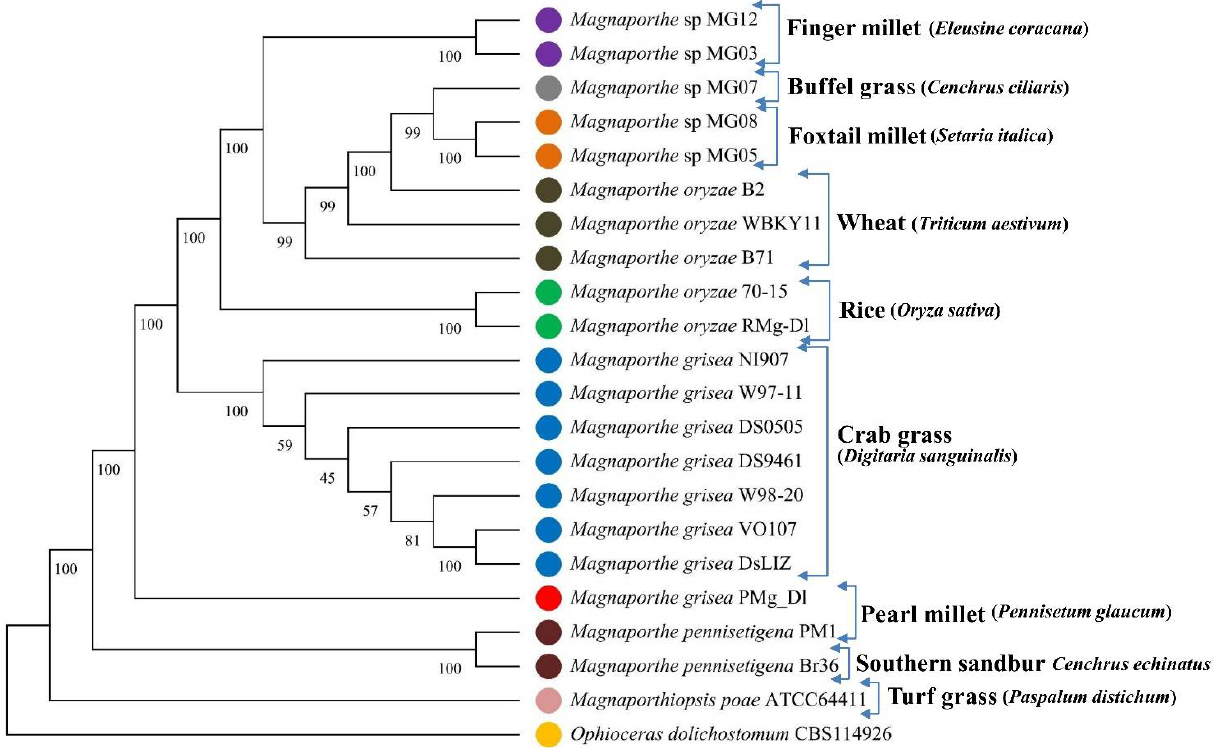
Figure 2. Phylogenetic tree of single-copy orthologous (SCO) proteins of 20 species belonging to Magnaporthe genera. The other two Magnaporthiopsis poae ATCC64411 from Magnaporthaceae and Ophioceras dolichostomum CBS114926 from Ophioceraceae were taken as an outgroup. The tree was generated using the concatenated 100 SCOs commons in all 22 species through maximum parsimony phylogeny with 1000 bootstrap method and search using subtree–prune–regraft (SPR), totaling 237,605 covered sites.